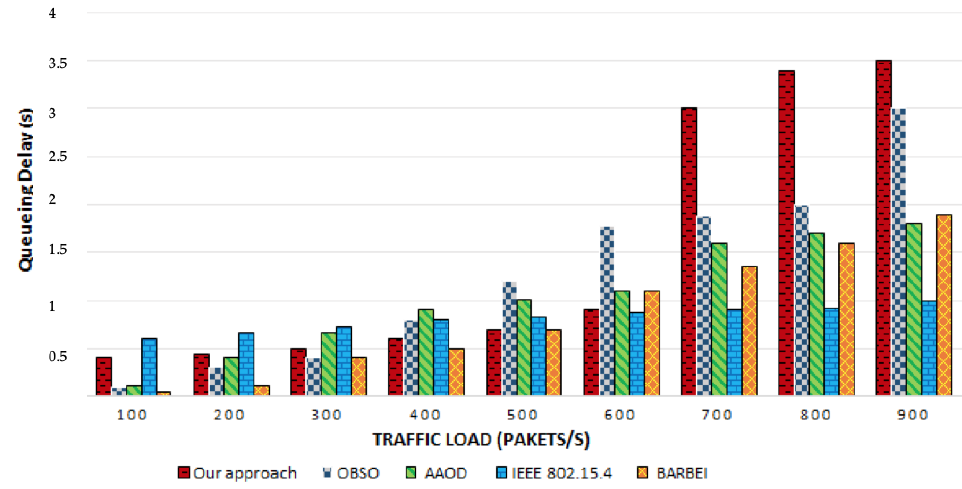
Figure 6. Queueing delay.